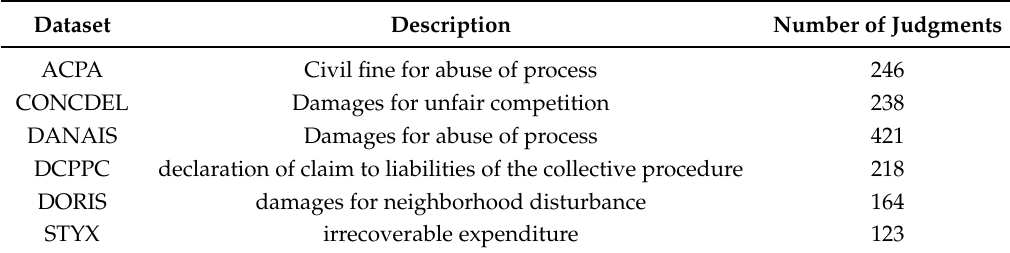
Table 1. Categories of claims of the